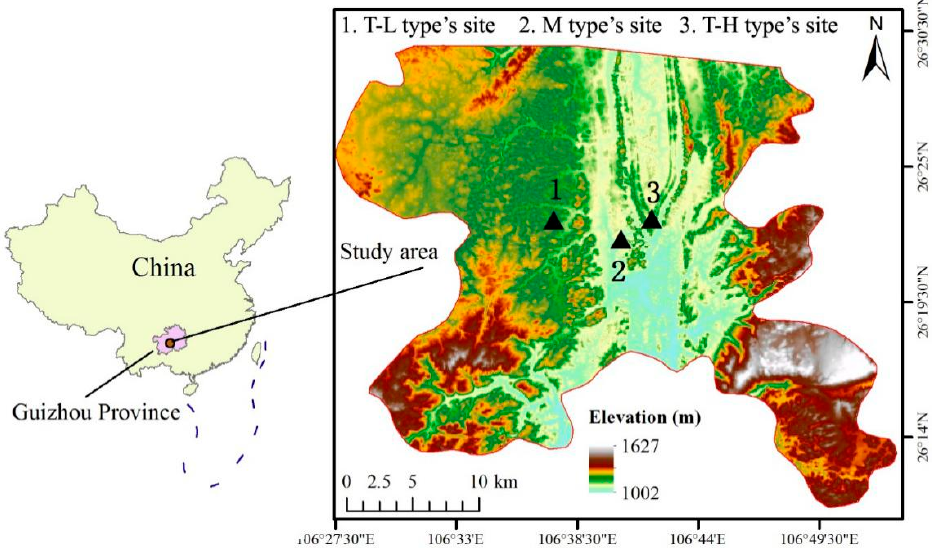
Figure 1. The location and elevation of the study area.